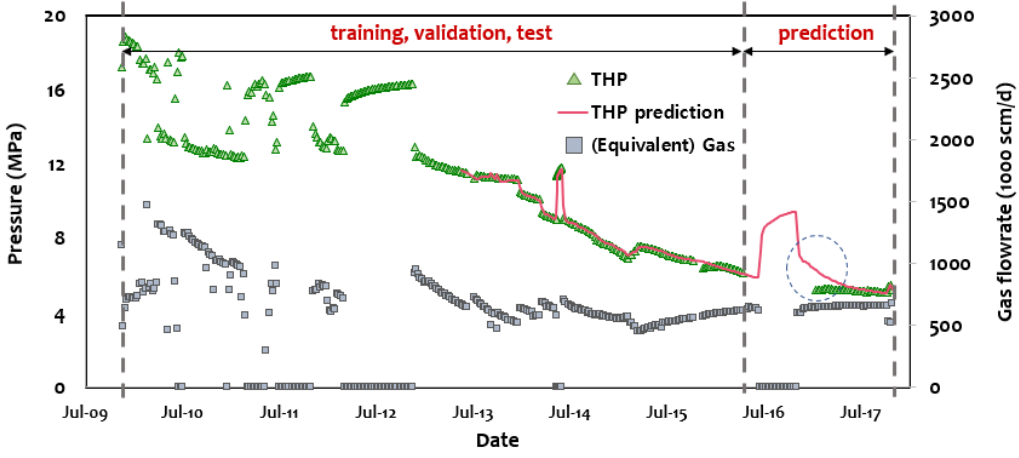
Figure 12. THP prediction results for Process 2.